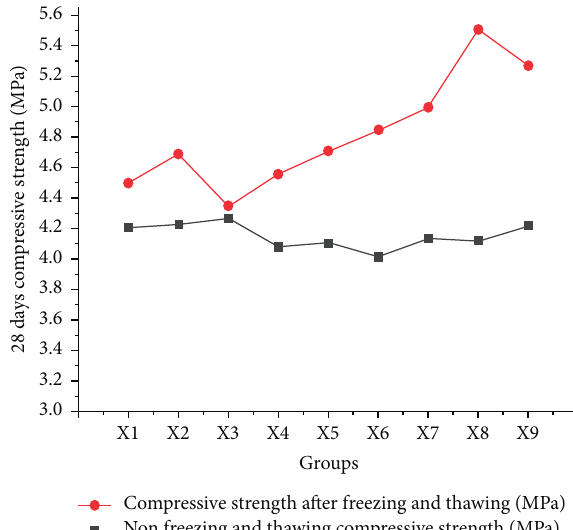
Figure 19: Comparison diagram of freeze-thaw results.